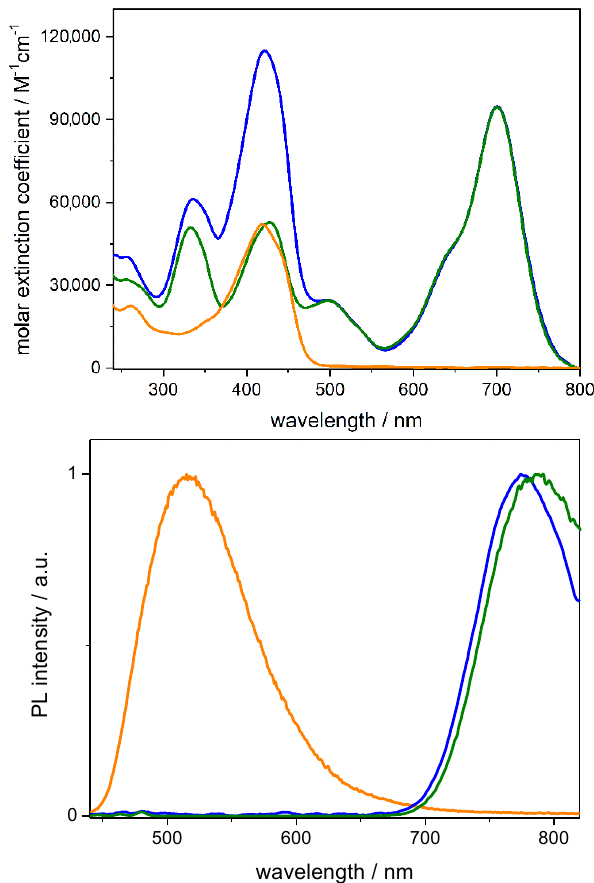
Figure 1. UV-Visible absorption ( top ) and emission ( bottom ) spectra of Curc (orange), 4 (green) and CB-Green (blue), recorded from micromolar acetonitrile solutions; emission was measured at λ exc = 420 nm. Please note that the absorption maxima at lower energy lies at 418 nm for Curc and at 705 nm for 4 and CB-Green